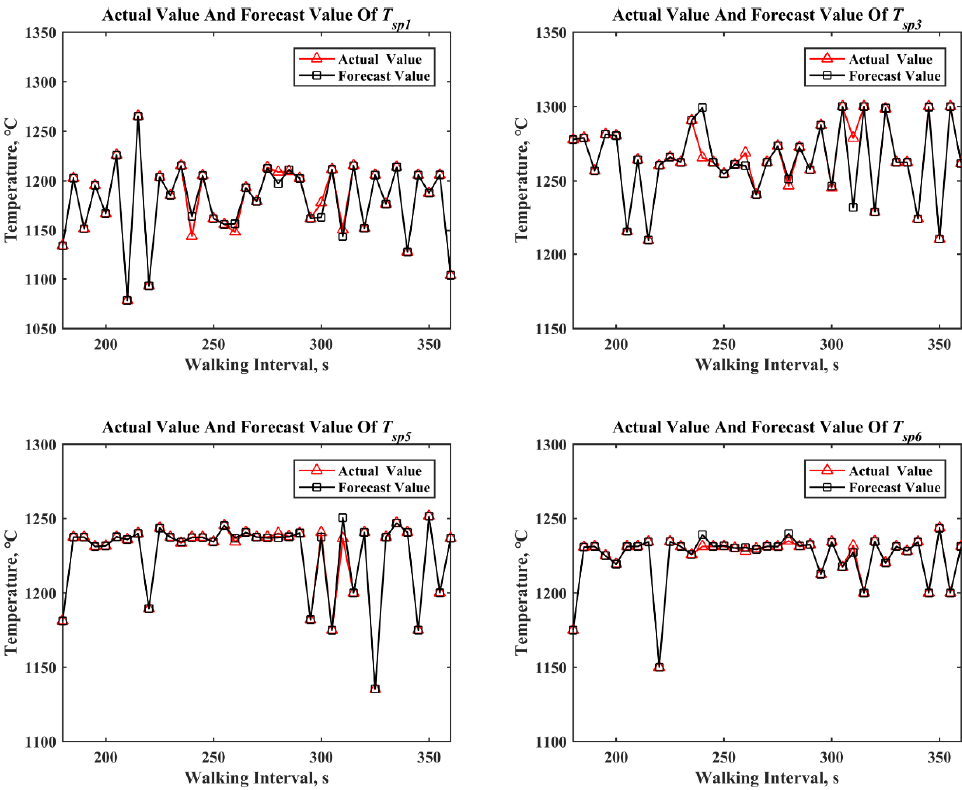
Figure 6. Actual value and forecast value of set-point temperatures.